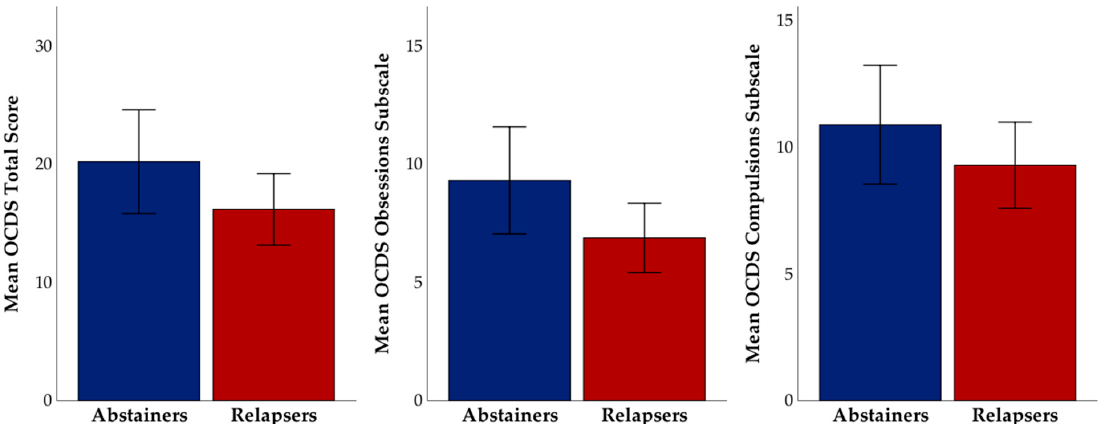
Figure 1. Mean Obsessive Compulsive Drinking Scale scores by relapse status at six months post-treatment. Specifically, those who went on to relapse reported lower craving than those who were able to maintain their abstinence. Next, we examined relapse rates and self-reported craving between the three COMT genotype groups. We found a trend toward significance between the three groups on OCDS total score (F(2,67) = 2.87, p = 0.06), and significant differences between groups on the obsessions subscale (F(2,67) = 3.22, p = 0.046). Pairwise comparisons revealed that observed differences were driven by Met/Met homozygotes, who reported the highest levels of craving (see Figure 2). Next, we tested if the frequency of relapse differed by COMT genotype. The Kruskal-Wallis test was not significant (H = 2.53, p = 0.28); however, it is worth noting the frequency of relapse by COMT genotype: Val/Val homozygotes had a relapse rate of 88.2%, Val/Met heterozygotes had a relapse rate of 66.7%, and Met/Met homozygotes had a relapse rate of 73.1% (see Figure 3). We examined all variables in logistic regression mediation and moderation analyses and found that the mediation model was not significant ( p = 0.31, Bootstrapped CI = − 0.026 to 0.014). However, the moderation model was significant such that OCDS total score (b =